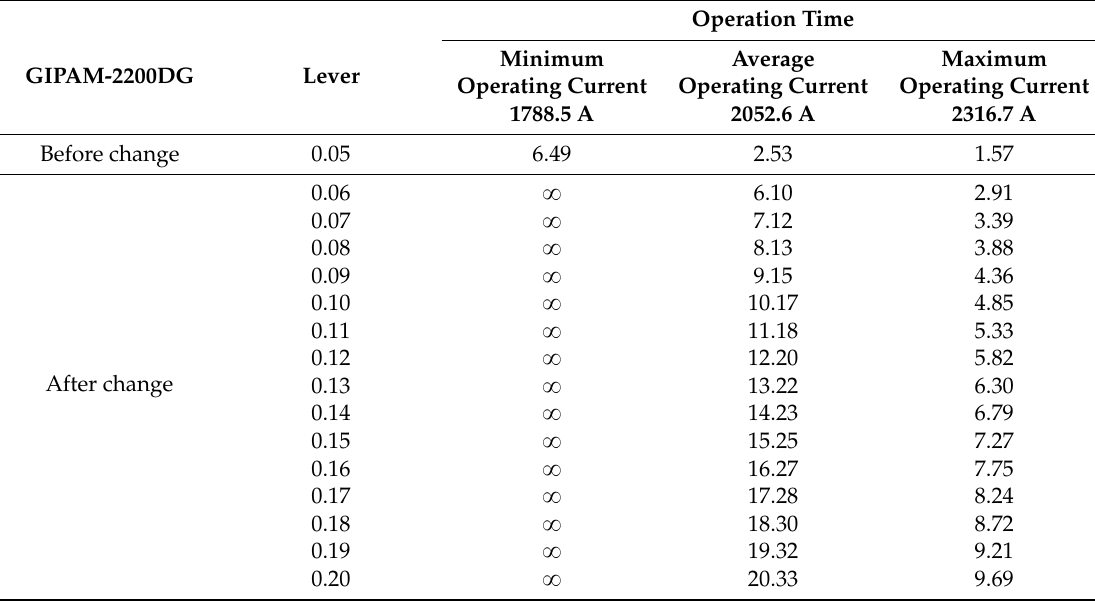
Table 5. Operation time according to lever of